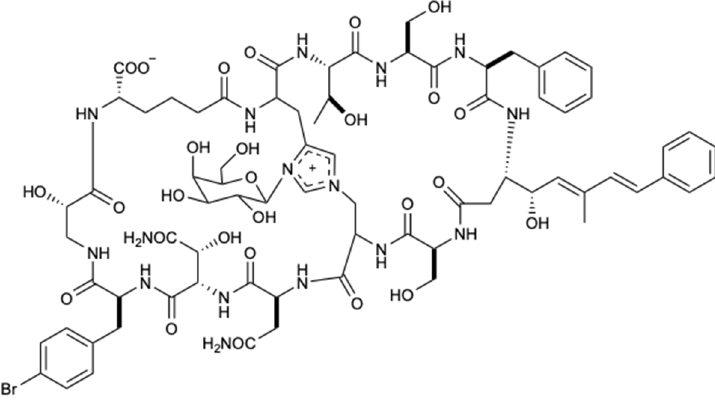
Figure 6. Structure of theonellamide G ( 9 ).